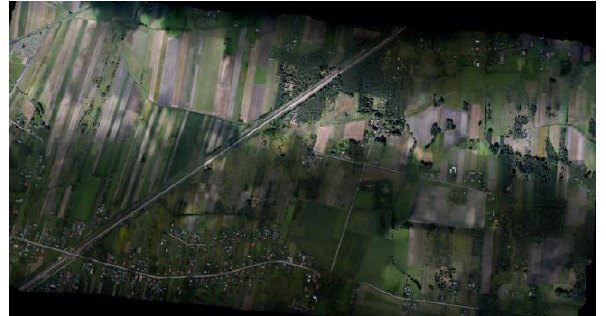
Figure 7. DSM obtained from the first data set (poor weather conditions) Figure 8. Orthomosaic from poor quality images